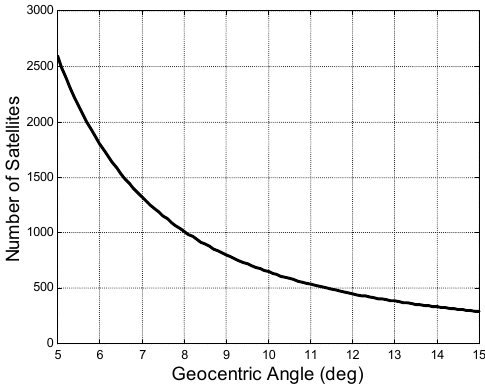
Figure 2. Total number of satellites in the design of the GeoSurf constellation. This number is independent of the altitude of the GeoSurf constellation. 𝑁 ranges from 2592 for 𝜑 = 5° to 288 for 𝜑 = 15° .